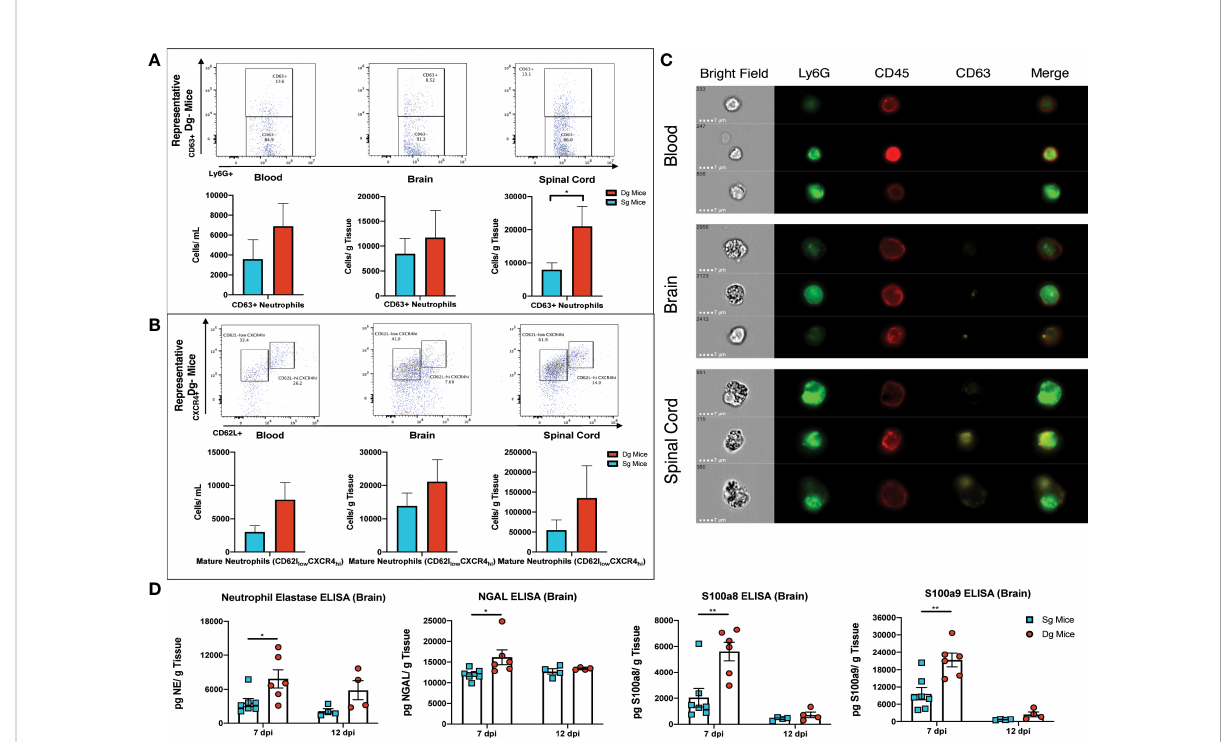
FIGURE 6 Neutrophils from JHMV-infected double-tg mice exhibit increased activation state (A) Representative fl ow plots reveal CD63+ neutrophils in the blood, brain, and spinal cord of JHMV-infected double-tg mice (n = 5) compared to infected single-tg (n = 7) control at day 12 p.i. Numbers of neutrophils in the spinal cord of infected double-tg mice are signi fi cantly (p < 0.05) increased compared to infected single-tg mice. (B) Representative fl ow plots showing mature neutrophils (CD45+Ly6g+CXCR4 hi CD62L low ) in blood, brain and spinal cords of JHMV-infected double-tg mice (n = 5) and infected single-tg mice (n = 7). (C) Representative ImageStream fl ow cytometry on neutrophils (CD45+Ly6G+) isolated from blood, brain and spinal cord obtained of JHMV-infected double-tg mice reveals enhanced CD63 expression in spinal cord-associated neutrophils. In addition, neutrophils from brains and spinal cords exhibited increased granularity compared to neutrophils obtained from the blood. For data in panels (A – C) , n = 5-7 mice per tissue type per group; 2 experiments. Representative fl ow plots are shown in panels (A, B). (D) JHMV-infected double-tg and single-tg mice were sacri fi ced at days 7 (n = 6-7 mice per group) and 12 p.i. (n = 4 mice per group) and levels of Neutrophil Elastase, NGAL, S100a8, and S100a9 determined by ELISA (3 independent experiments). *p < 0.05, **p <